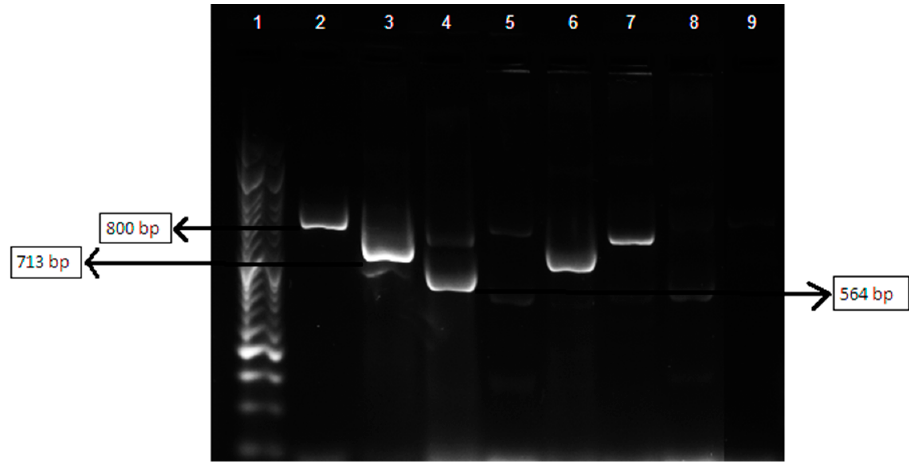
Figure 3. Amplification products of bla TEM , bla SHV and bla OXA . Lane 1—NZYDNA Ladder VI; Lane